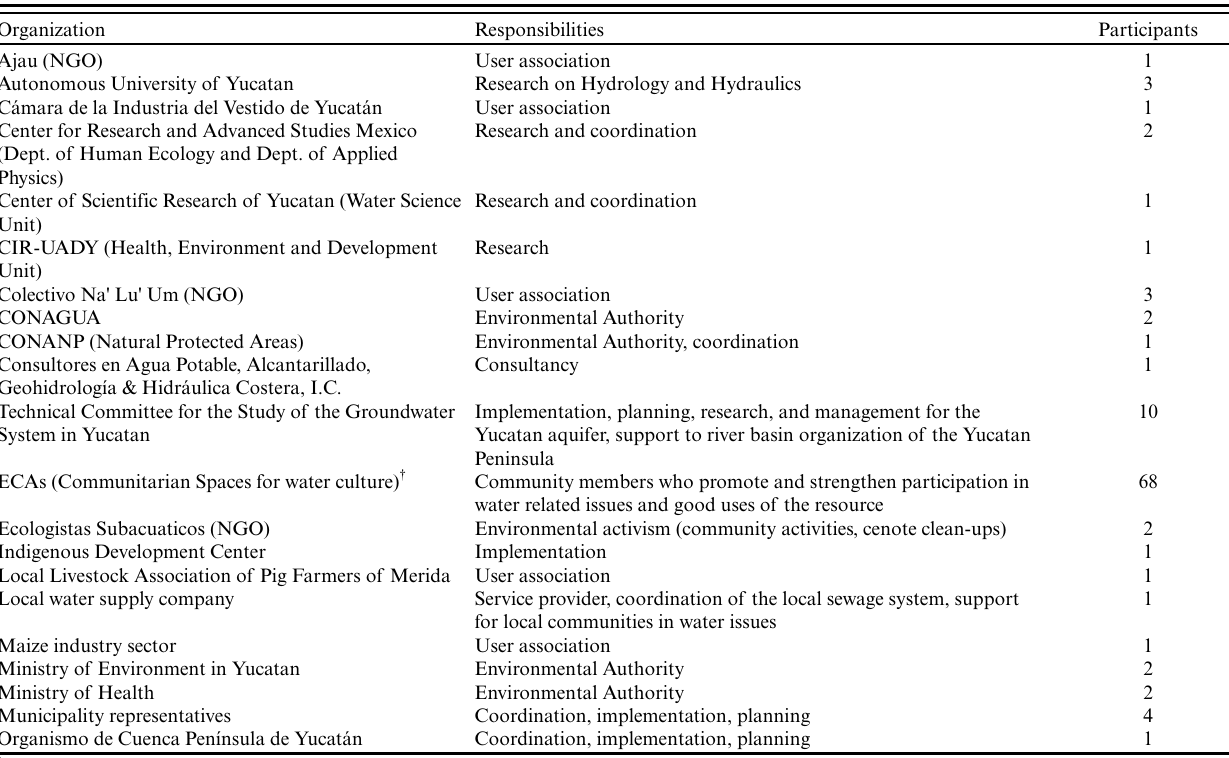
Table 2 . Organizations represented in the interviews, and their roles and responsibilities, in the analysis of the cenotes in Yucatan. Organization